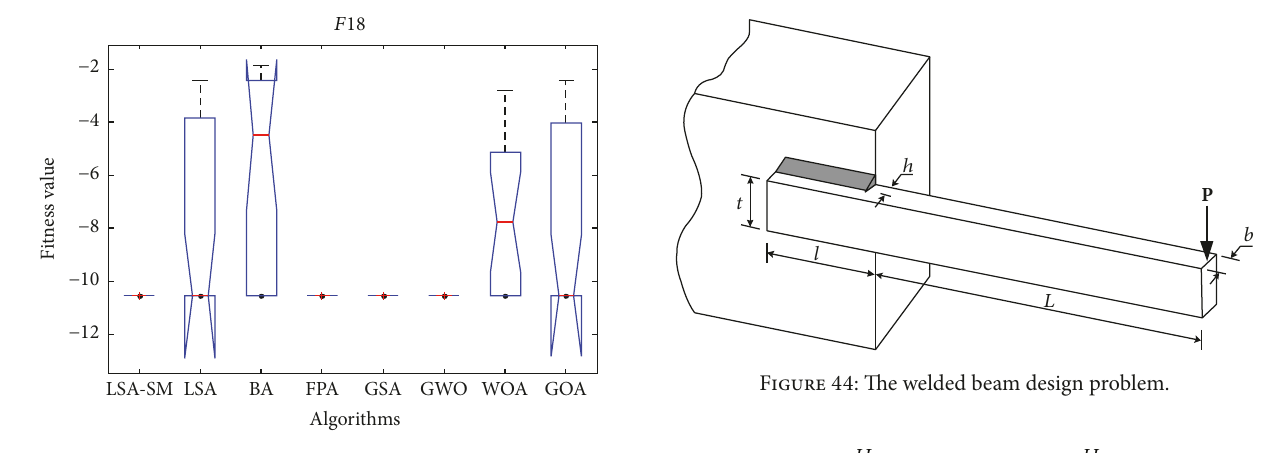
Figure 40: 𝐷 = 4 , ANOVA test of global minimum for 𝑓 18 .